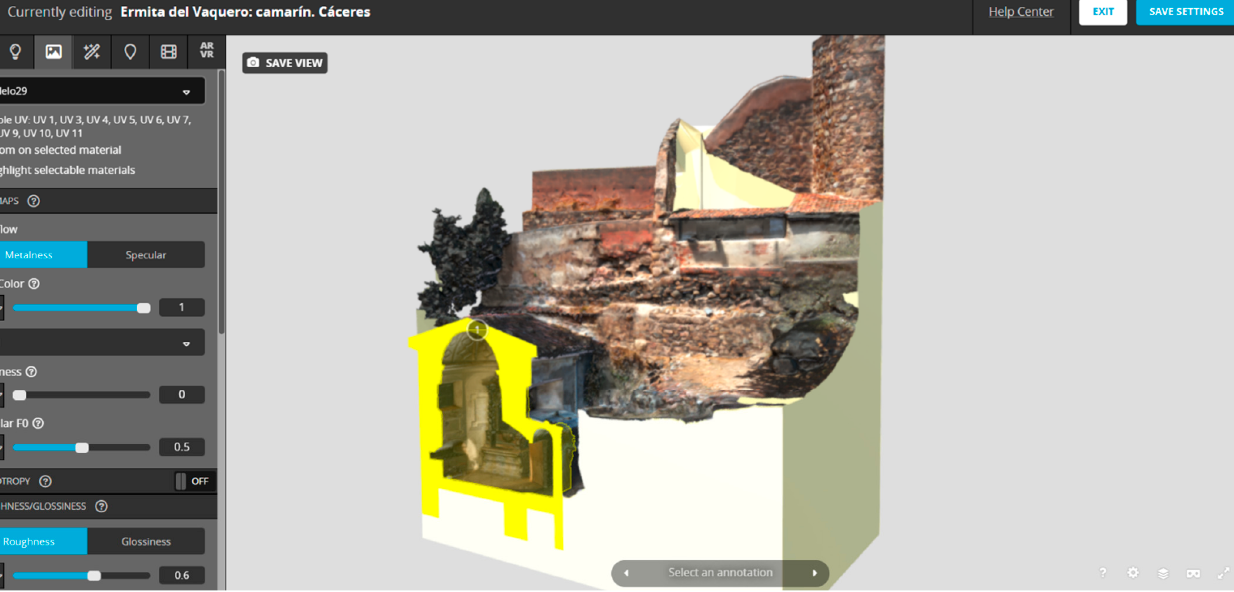
Figure 17. Sketchfab interface. Setting up